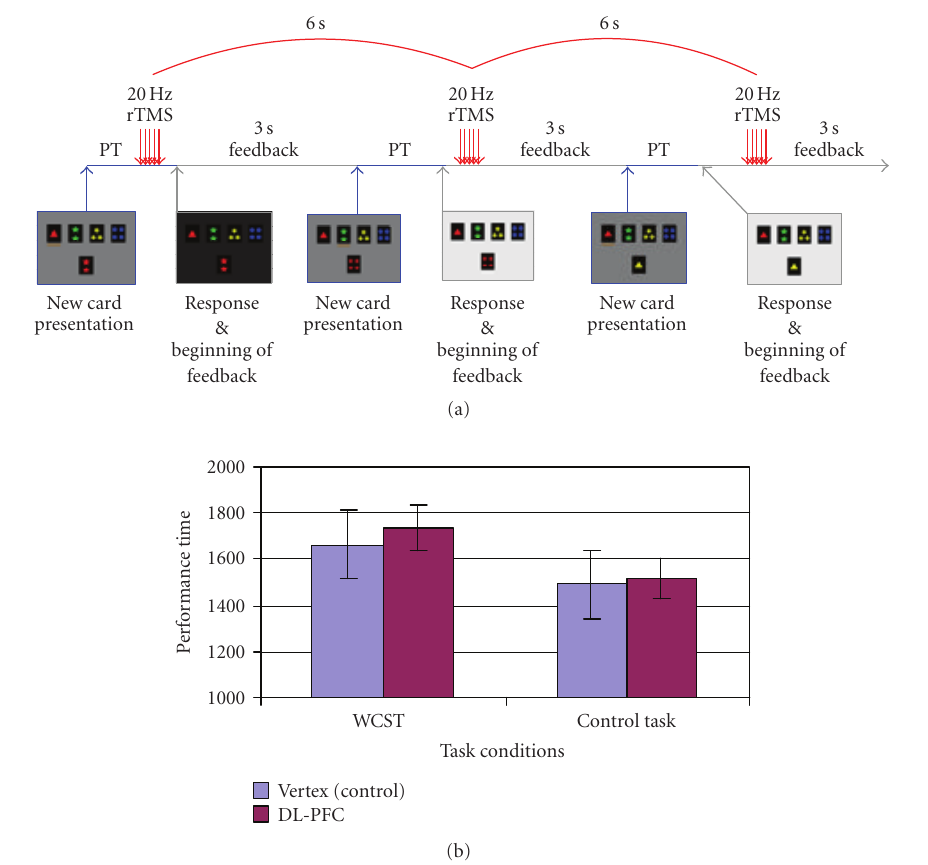
Figure 6: (a) Desynchronized rTMS: while the subject performed the WCST or control task, rTMS was applied over the right DL-PFC or vertex at every 6 seconds which was desynchronized with the tasks. (b) Desynchronized DL-PFC stimulation had no e ff ect on PT compared to the vertex